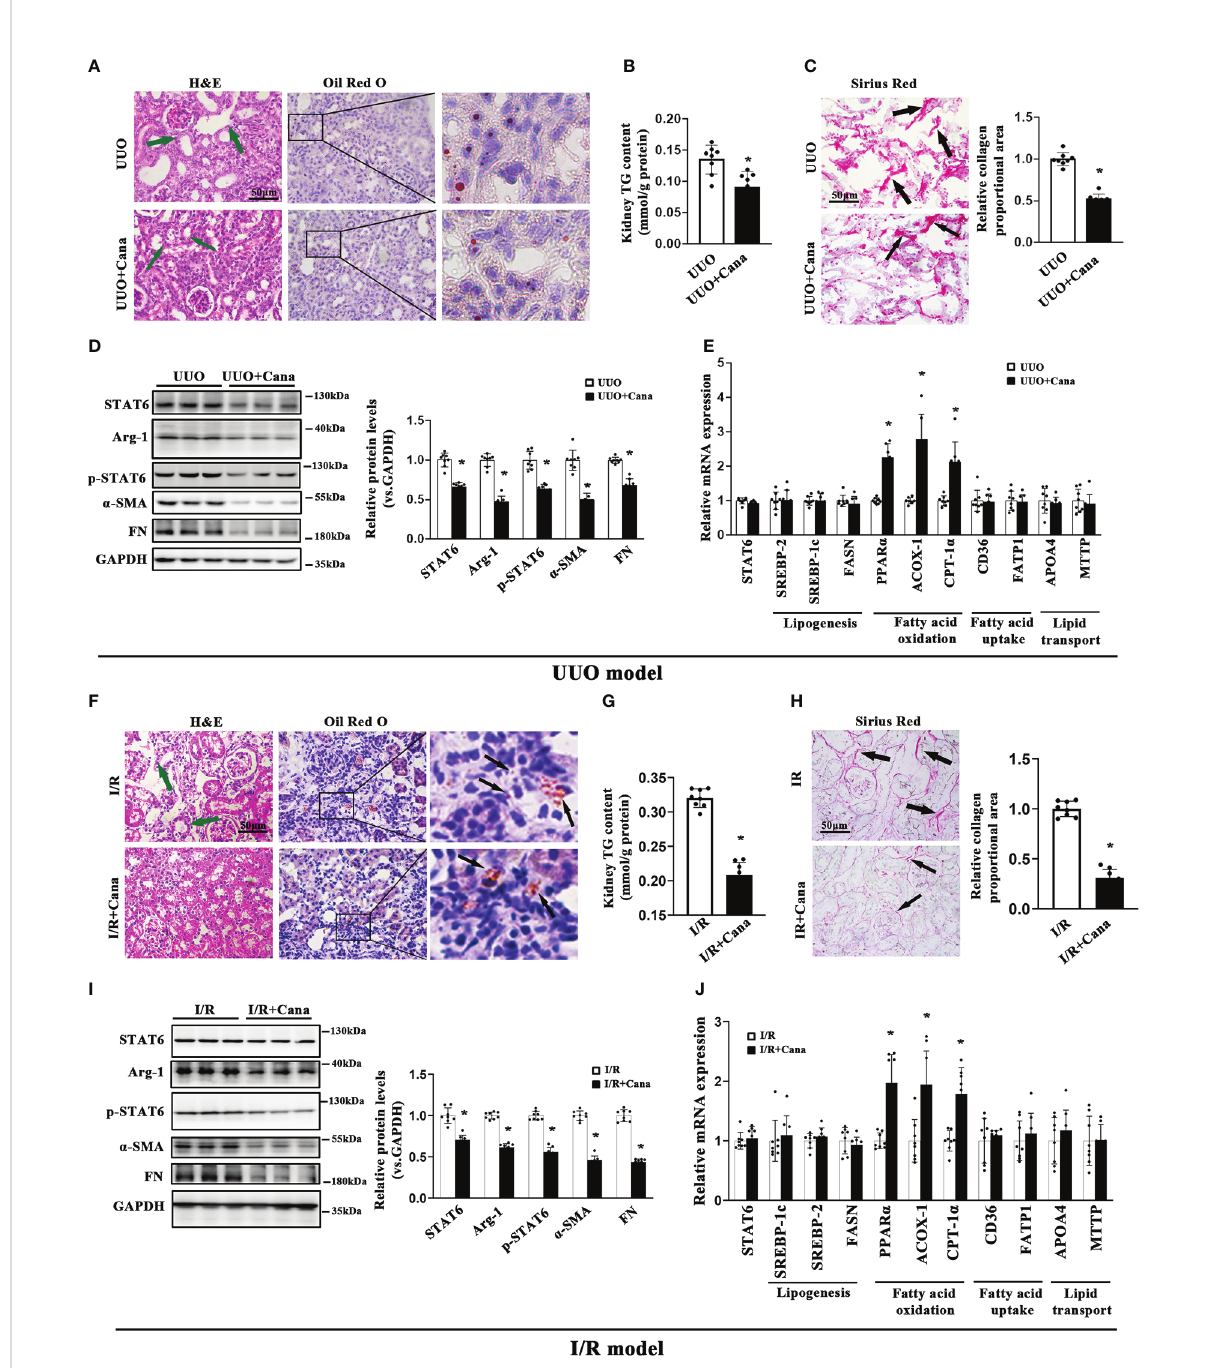
FIGURE 2 Cana intervention attenuated aberrant lipid metabolism and tubulointerstitial fi brosis in UUO or I/R mice. A tubulointerstitial fi brosis model was conducted by UUO or I/R operation. The mice of UUO or UUO+Cana were sacri fi ced at day 7, and mice of I/R or I/R+Cana were sacri fi ced at day 21. (A) Representative micrographs for H&E and Oil Red O staining in the kidney sections from the indicated groups. (B) TG content was determined in the kidneys from the indicated groups. (C) Representative micrographs for Sirius Red staining and quanti fi cation of relative collagen proportion in the kidneys from the indicated groups. (D) Kidney tissue lysates from each group were subjected to immunoblot analyses with the indicated antibodies. Representative blots of three independent samples in each group were shown, and quanti fi cation of relative protein expression was determined. (E) The mRNA levels of genes related to lipid metabolism in the kidneys from the indicated groups. Mice received intragastric administration of saline or Cana intervention after IR operation. (F) H&E and Oil Red O staining, (G) TG content, (H) Sirius Red staining, (I) immunoblot analyses, and (J) qPCR. Results were expressed as the mean ± SD (n = 8, * p < 0.05, UUO vs. UUO + Cana or IR vs. IR +